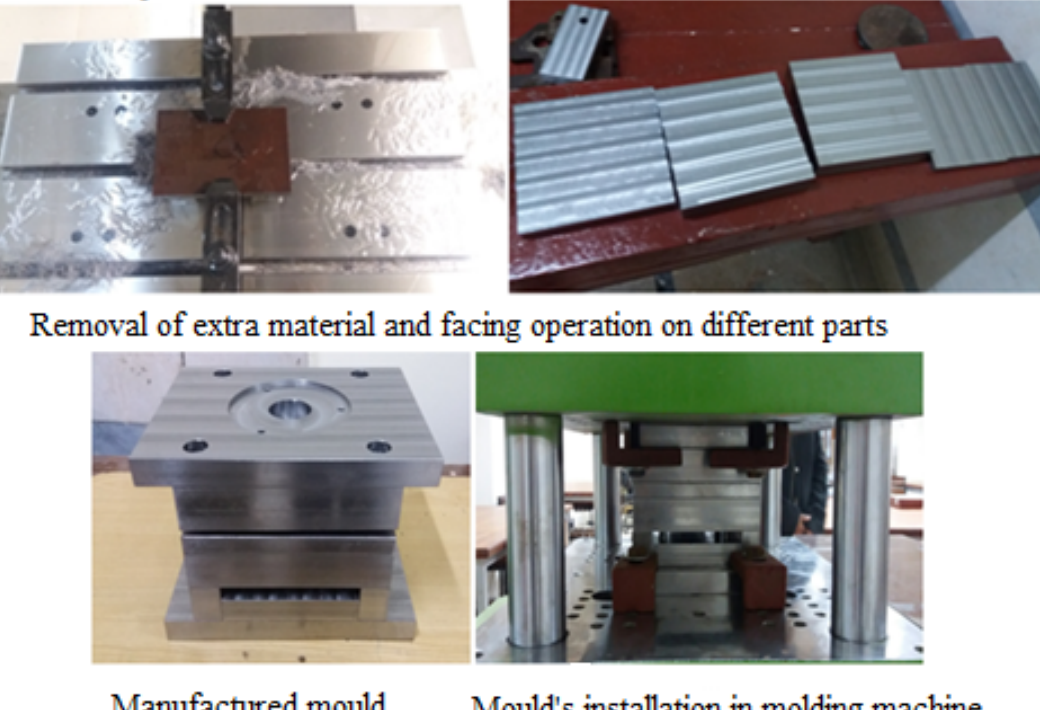
Figure 5. Various phases of mould manufacturing.